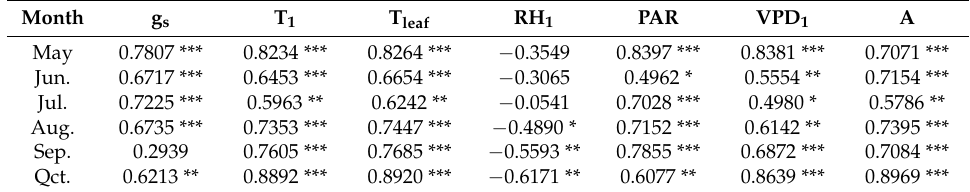
Table 3. Summary of correlations (Pearson) between transpiration rates ( T r , mmol H 2 O m − 2 s − 1 ) of S. passerina and other gas exchange parameters.